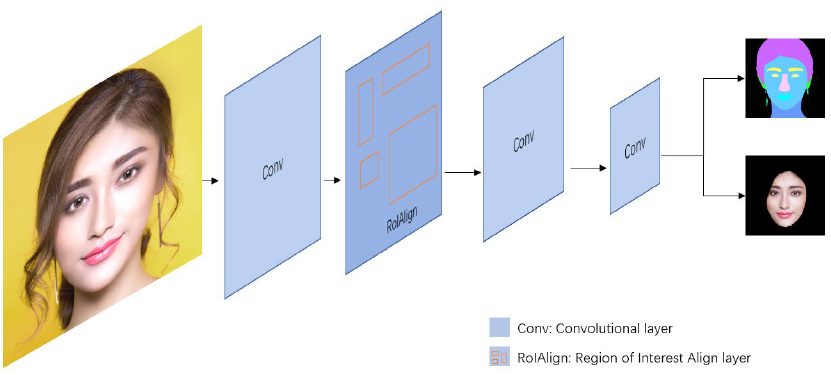
Figure 2. Face segmentation (F) module.